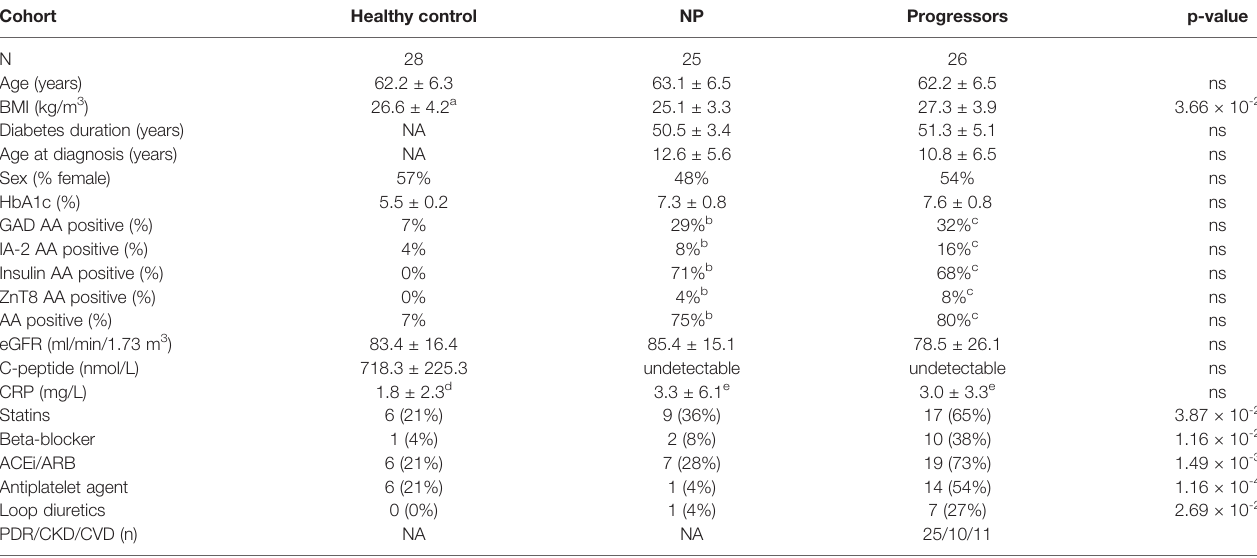
TABLE 1 | Clinical characteristics of the DIALONG study